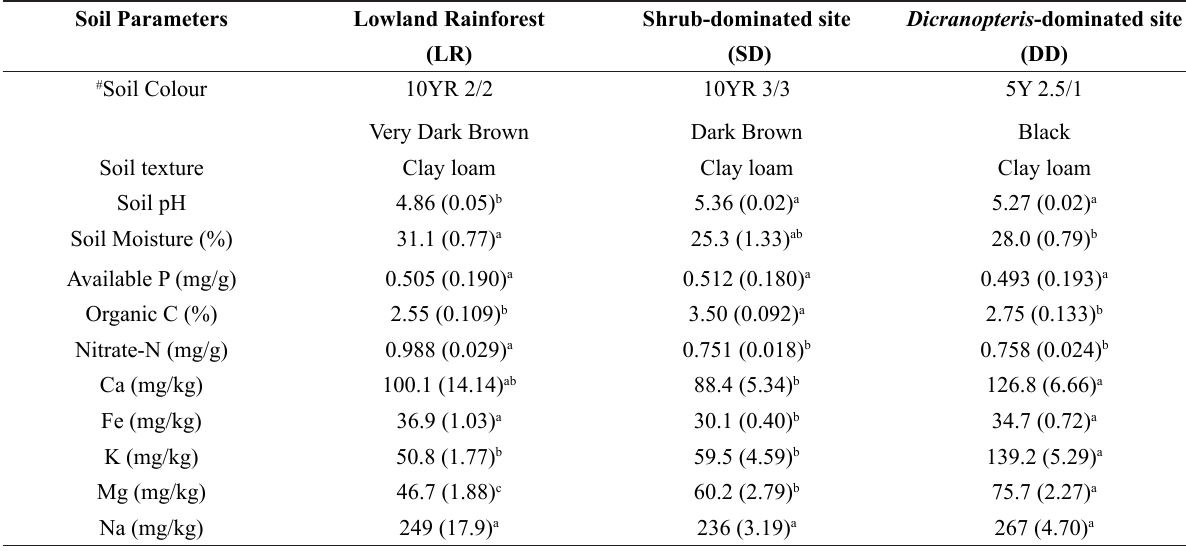
Table 1: Mean values (±SEM) of some soil chemical and physical characteristics of the three land use types, Dicranopteris - dominated (DD), lowland rainforest (LR) and shrub-dominated (SD), at Kanneliya Forest Reserve in Sri Lanka. Different letters indicate significant differences between means of different land use types Dicranopteris -dominated site Soil Parameters Lowland Rainforest Shrub-dominated site (LR) (SD) (DD) # Soil Colour 10YR 2/2 Very Dark Brown Soil texture Clay loam Soil pH Soil Moisture (%) Available P (mg/g) Organic C (%) Nitrate-N